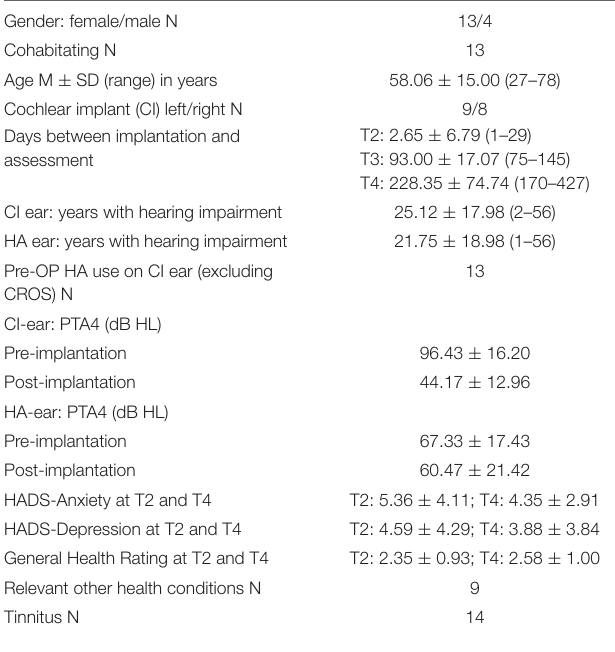
TABLE 1 | Participants’